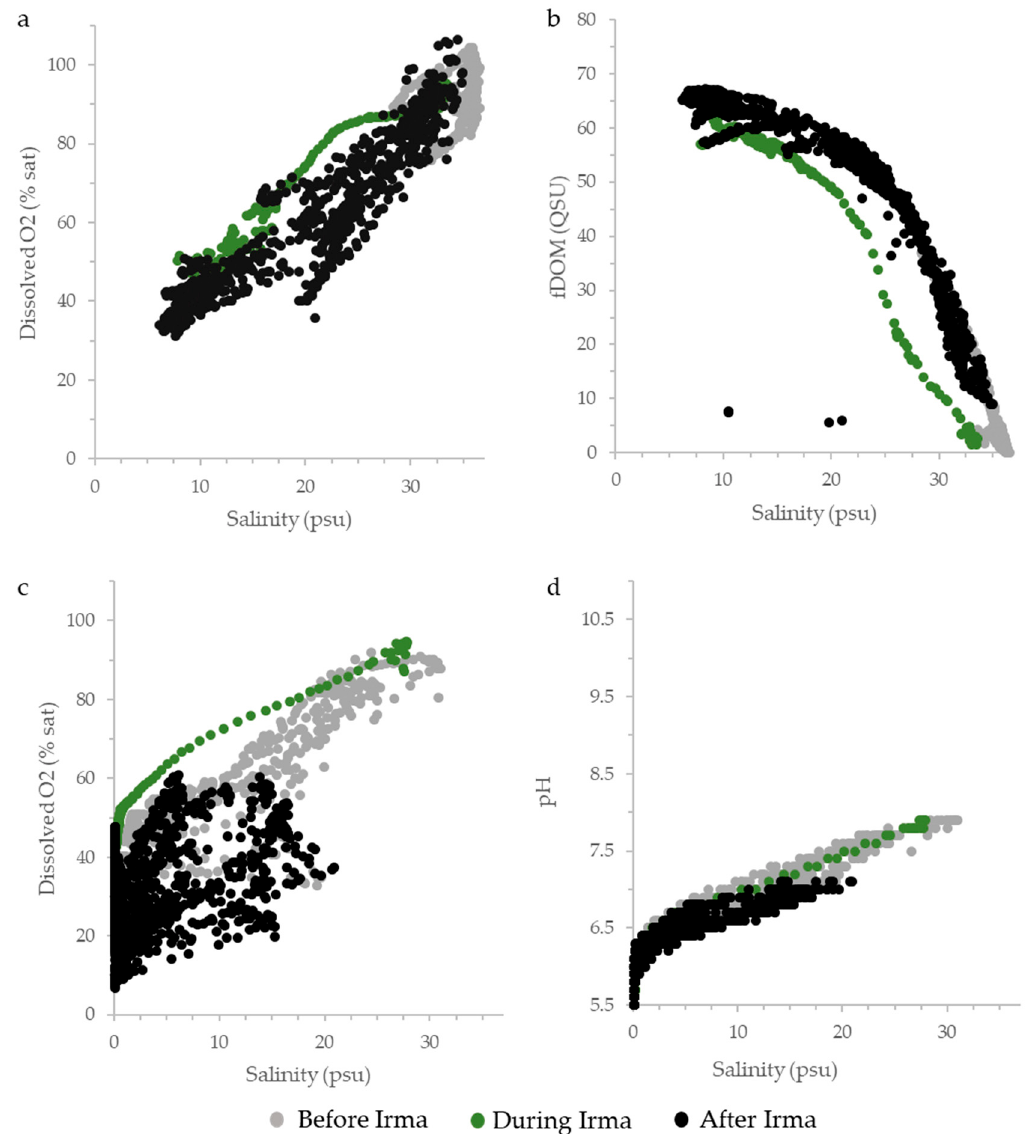
Figure 7. Correlations from before (grey), during (green), and after (black Hurricane Irma compared for a series of parameters: ( a ) dissolved oxygen and salinity within the estuary, ( b ) fDOM and salinity at the estuary, ( c ) dissolved oxygen and salinity in the middle reaches, ( d ) pH and salinity in the middle reaches. This data was collected by YSI data sondes from September 7 to September 22, 2017. * Hurricane Irma affected the study area between September 10 and 11, 2017